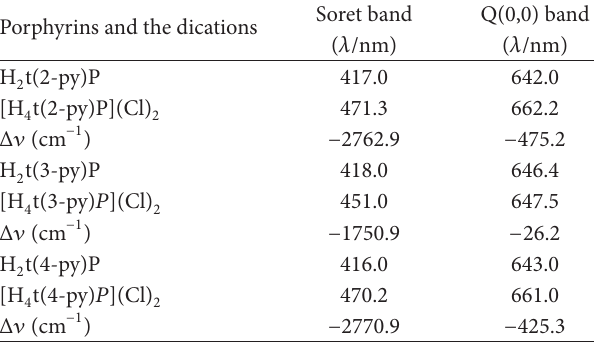
T 2: UV-vis spectral data for the interaction of H Cl 2a . HCl in CH 2